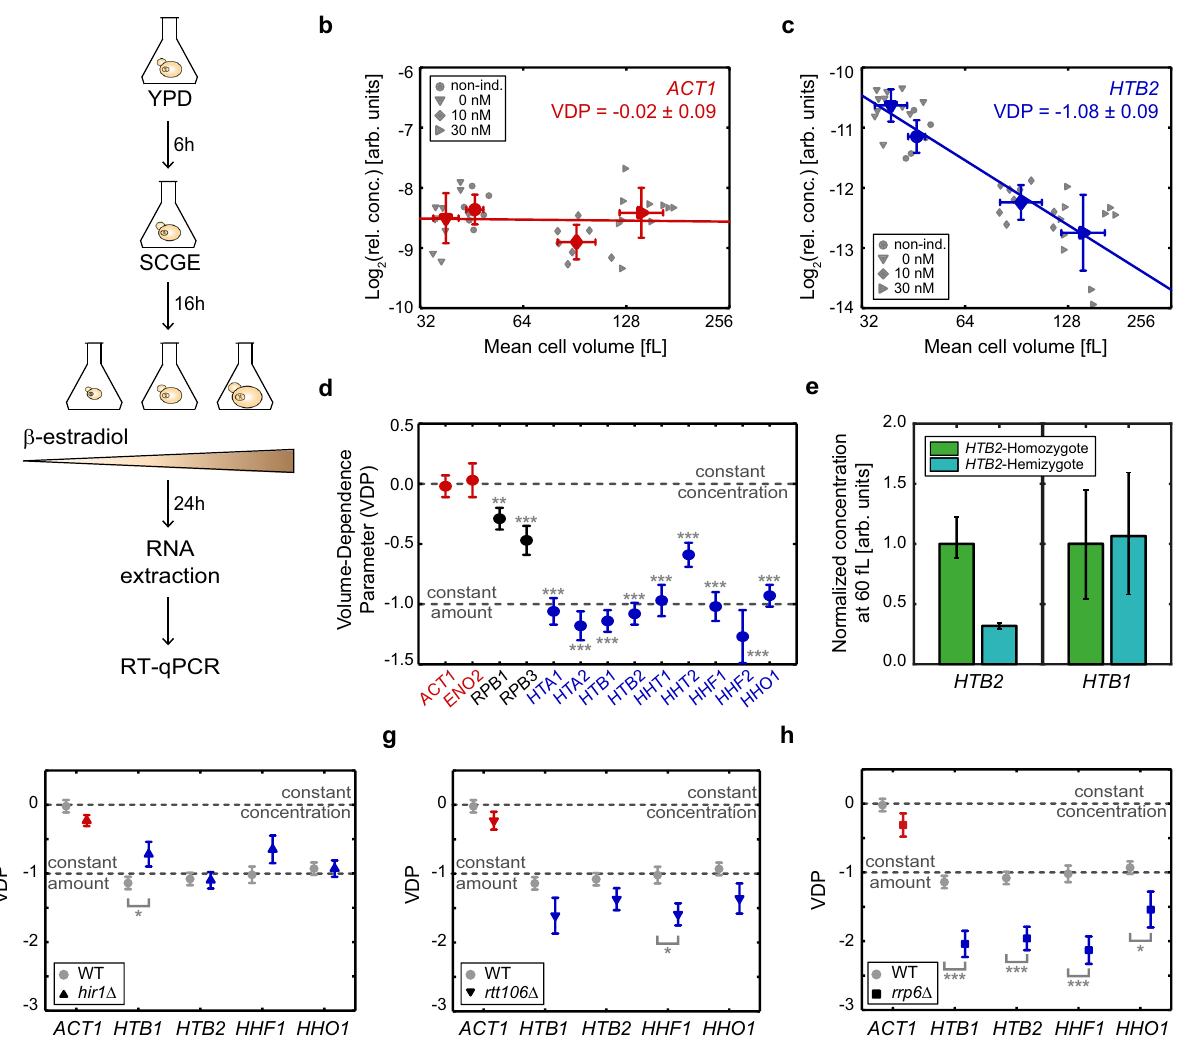
Fig. 2 Histone mRNA concentrations decrease with cell volume and increase with gene copy number. a Experimental procedure for RT-qPCR measurements. Cells were grown for at least 24h at the respective β -estradiol concentration before extracting total RNA and performing RT-qPCR. b , c Relative ACT1 ( b ) or HTB2 ( c ) mRNA concentrations (normalized on RDN18 ) for non-inducible and inducible haploid cells over mean cell volume are shown in a double- logarithmic plot. Individual data points for the different conditions (down-pointing triangles for 0nM, circles for non-inducible, diamonds for 10nM, right- pointing triangles for 30nM) are shown in gray. Red ( b ) or blue ( c ) symbols indicate the mean of the different conditions with error bars indicating the standard ¼ 7 ; n ACT1 deviations for n ACT1 0 non (cid:1) ind : show linear fi ts to the double-logarithmic data, with volume-dependence parameters (VDPs) determined as the slope of the fi t. d Summary of the VDPs for all ¼ 34, n ¼ 26, n ¼ 26, n ¼ 25, n ¼ 27, n ¼ 30, measured genes with error bars indicating the standard error ( fi t through n ACT1 ENO2 RPB1 RPB3 HTA1 HTA2 n HTB1 ¼ 36, n HTB2 ¼ 37, n HHT1 ¼ 37, n HHT2 ¼ 30, n HHF1 ¼ 31, n HHF2 ¼ 37, and n HHO1 ¼ 37 biological replicates); signi fi cance that the VDP is different from 0 ¼ 4 : 1 (cid:3) 10 (cid:1) 3 , *** p ¼ 9 : 0 (cid:3) 10 (cid:1) 4 , *** p ¼ 1 : 5 (cid:3) 10 (cid:1) 9 ; *** p ¼ 1 : 8 (cid:3) 10 (cid:1) 10 , *** p ¼ 7 : 2 (cid:3) 10 (cid:1) 14 , was tested using linear regressions: ** p RPB1 RPB3 HTA1 HTA2 HTB1 *** p HTB2 ¼ 8 : 0 (cid:3) 10 (cid:1) 14 , *** p HHT1 ¼ 1 : 1 (cid:3) 10 (cid:1) 8 ; *** p HHT2 ¼ 5 : 4 (cid:3) 10 (cid:1) 6 , *** p HHF1 ¼ 2 : 2 (cid:3) 10 (cid:1) 9 , *** p HHF2 ¼ 1 : 2 (cid:3) 10 (cid:1) 6 , *** p HHO1 ¼ 8 : 3 (cid:3) 10 (cid:1) 13 . e Median mRNA concentrations at 60fL, estimated from the linear fi t to the double-logarithmic dependence of concentration on cell volume, for HTB2 (left) and HTB1 (right) in diploid HTB2 homozygous (green, fi t through n HTB2 ¼ n HTB1 ¼ 18 biological replicates) and HTB2/htb2 Δ hemizygous (teal, fi t through n HTB2 ¼ n HTB1 ¼ 18 biological replicates) strains, normalized on the respective median concentration of the HTB2 -homozygote. Error bars indicate the 2.5- and 97.5-percentiles around the median concentration ratio, determined from 10000 bootstrap samples. f – h Summary of VDPs for hir1 Δ ( f ), rtt106 Δ ( g ), as well as rrp6 Δ ( h ) ¼ 30, n hir 4 ¼ 28, n hir 4 ¼ 30, n hir 4 ¼ 30, n hir 4 ¼ 30 ( f ), n rtt106 4 ¼ 12, deletion strains. Error bars indicate the standard error of the VDPs ( fi t through n hir 4 ACT1 HTB1 HTB2 HHF1 HHO1 ACT1 ¼ 2 : 7 (cid:3) 10 (cid:1) 2 ( f ), * p rtt106 4 ¼ 2 : 3 (cid:3) 10 (cid:1) 2 ( g deviation from the wild-type VDP (carrying no deletion) was tested using linear regressions; * p hir 4 HTB1 HHF1